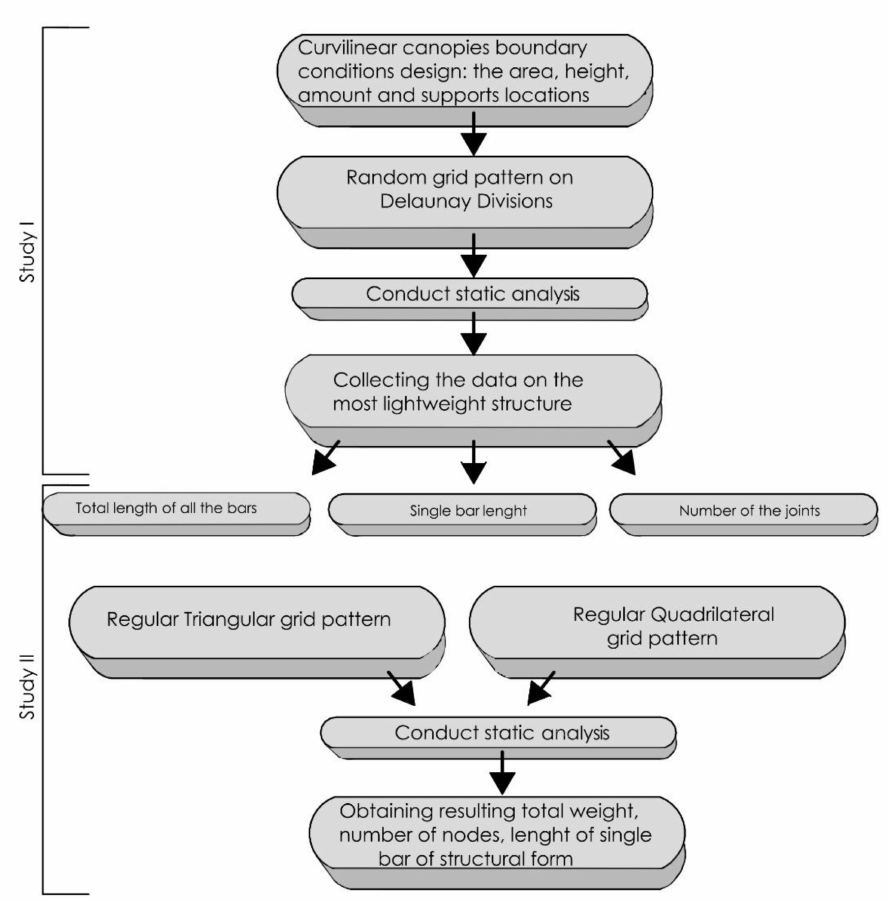
Figure 4. The Methodology flowchart of conducted theoretical studies (authors